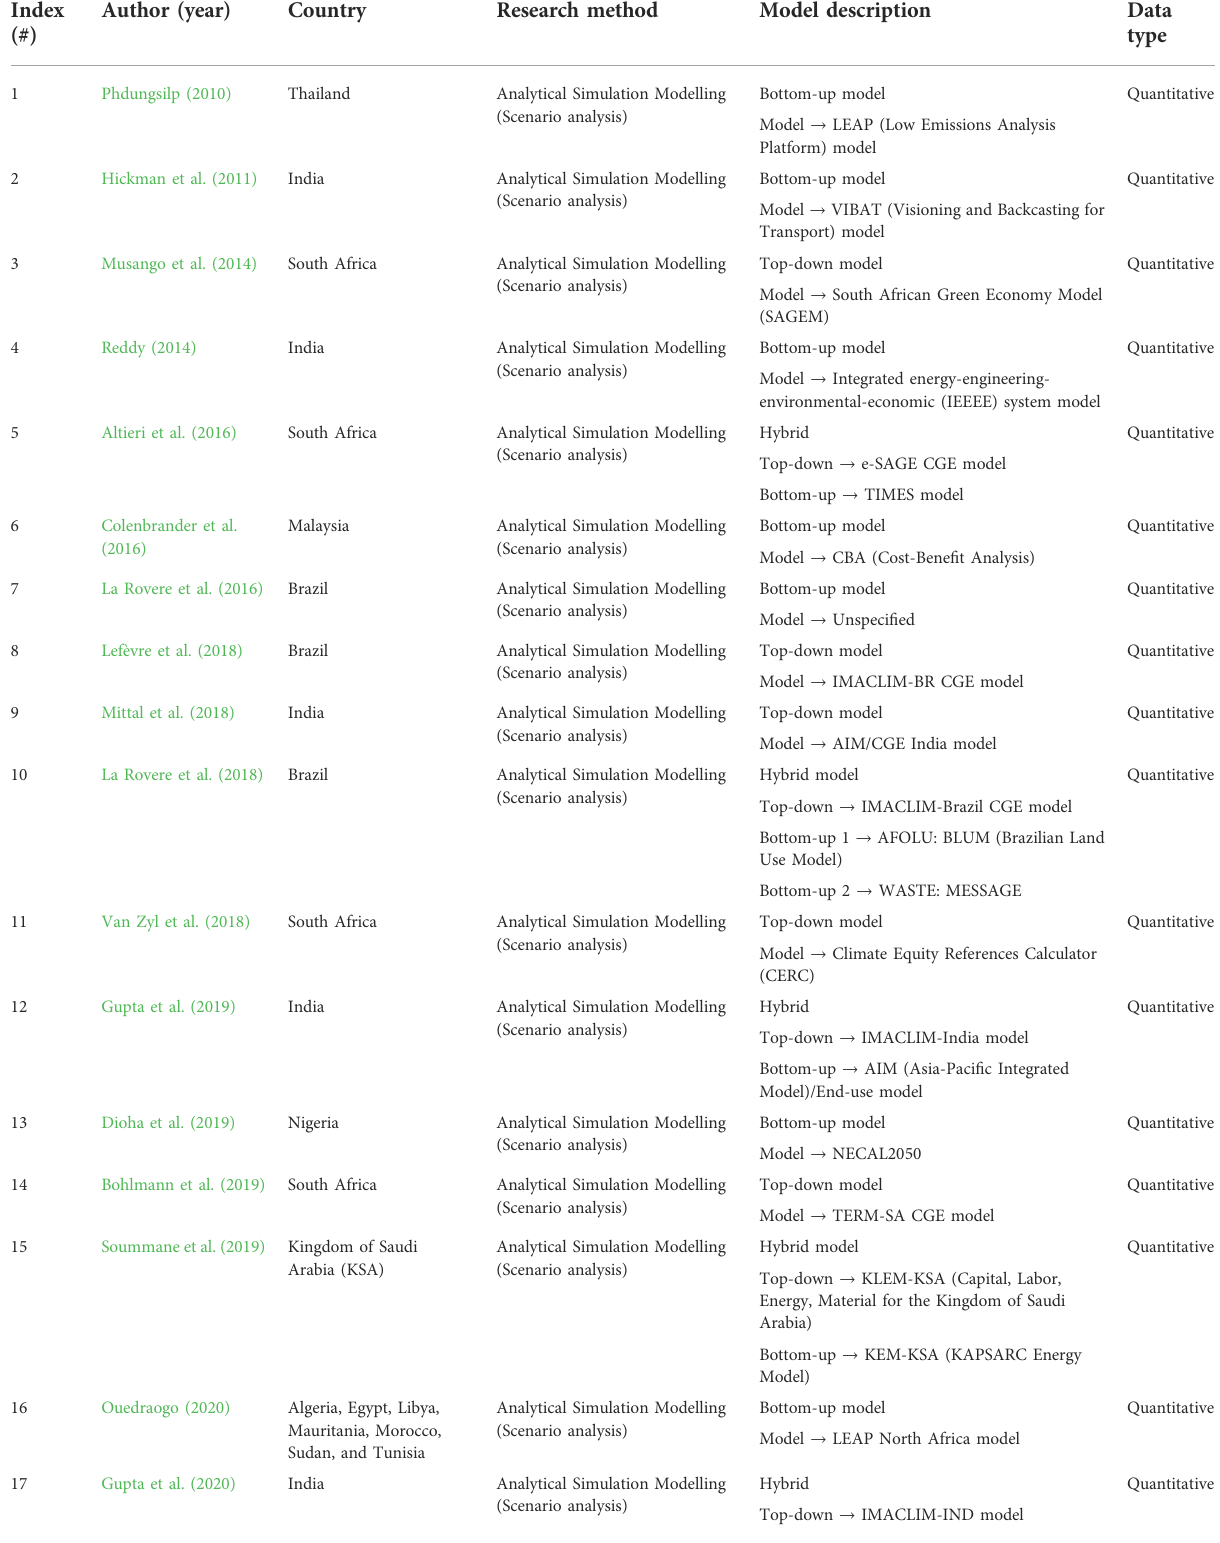
TABLE 3 Multi-level economic coverage of the reviewed